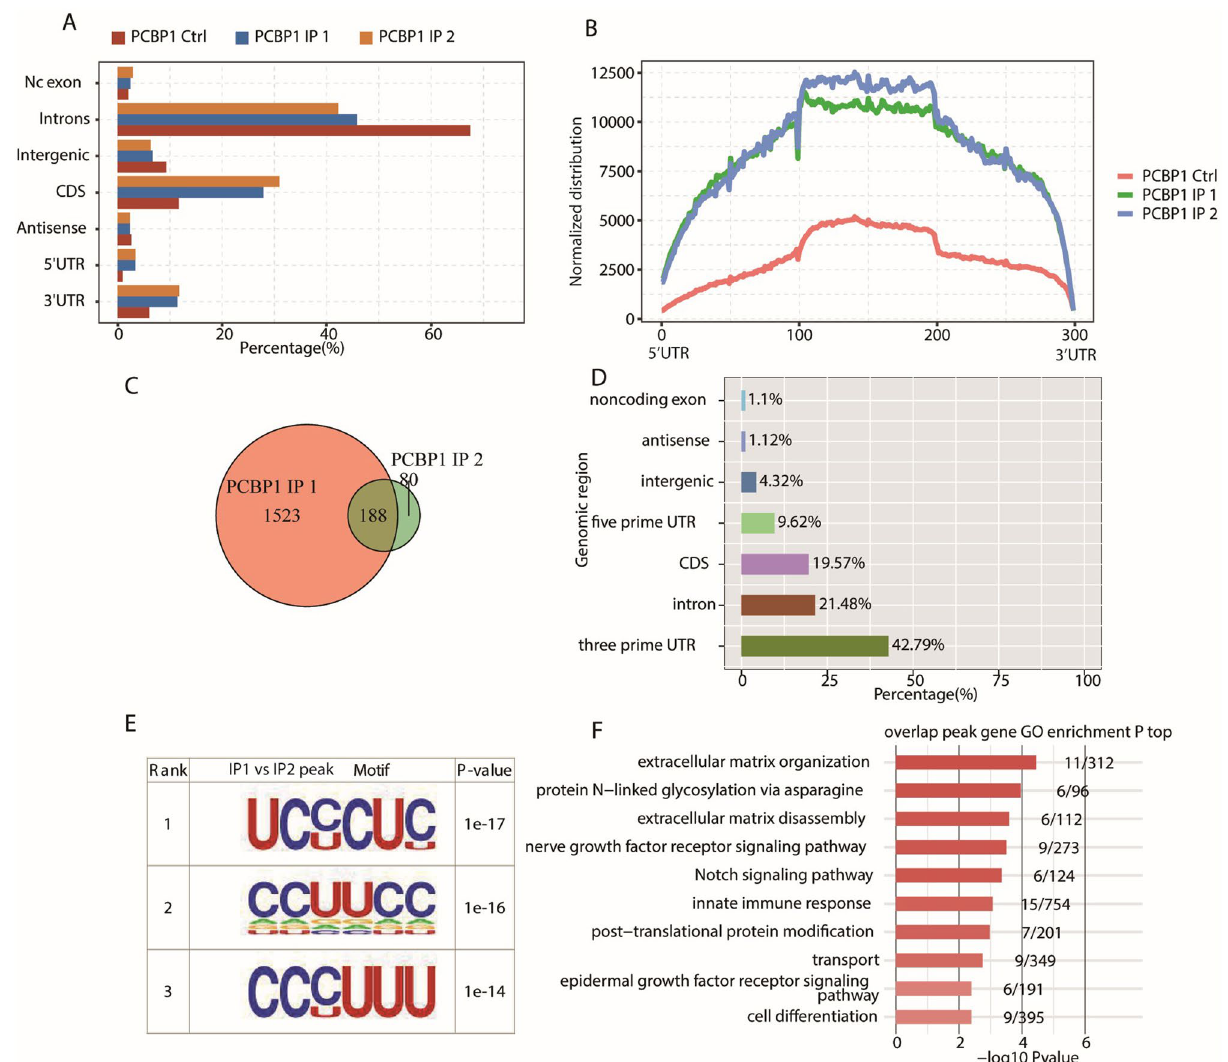
Figure 3. Analysis of binding characteristics of PCBP1. ( A ) Bar plot showing the reads distribution across different genomic regions. ( B ) Peak reads density in 5 ′ UTR, CDS and 3 ′ UTR. These three regions of each gene were separated into 100 bins, the PCBP1 peak reads in each bin was calculated. The reads density of PCBP1 peaks in all genes were plotted. ( C ) Venn diagram showing the overlapped peaks in two IP samples. ( D ) Bar plot showing the distribution of overlapped peaks across different genomic regions. ( E ) Motif analysis showing the top 3 preferred bound motifs of PCBP1 using HOMER software. ( F ) Bar plot exhibited the most enriched GO biological process results of PCBP1-bound genes. PCBP1, Poly C Binding Protein 1; UTR, untranslated terms (Fig. 4D), posttranslational protein modification, cellular lipid metabolic process and regulation of tran- scription from the RNA polymerase II promoter were closely related to malignant tumour biological behaviour. The enriched KEGG pathways of the overlapping gene regions and genes ( P > 0.05) included those involved in bacterial invasion of epithelial cells, protein processing in endoplasmic reticulum and Vibrio cholerae infection, and endocrine resistance (Supplementary Fig. S2A, B). The genes involved in these GO terms and KEGG path- ways are presented in Supplementary Table S7. Further validation of PCBP1‑regulated gene expression and AS.